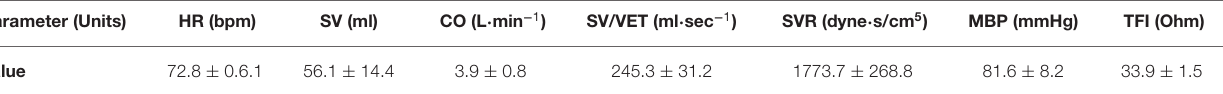
TABLE 2 | Absolute hemodynamic and metabolic data in divers at rest preceding the apnoeas. Parameter (Units)